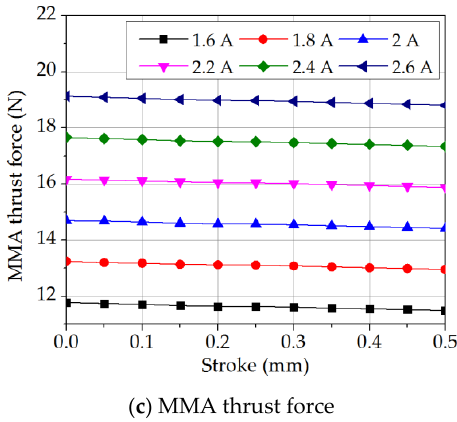
Figure 13. Thrust force, applied current, and stroke length relationships.